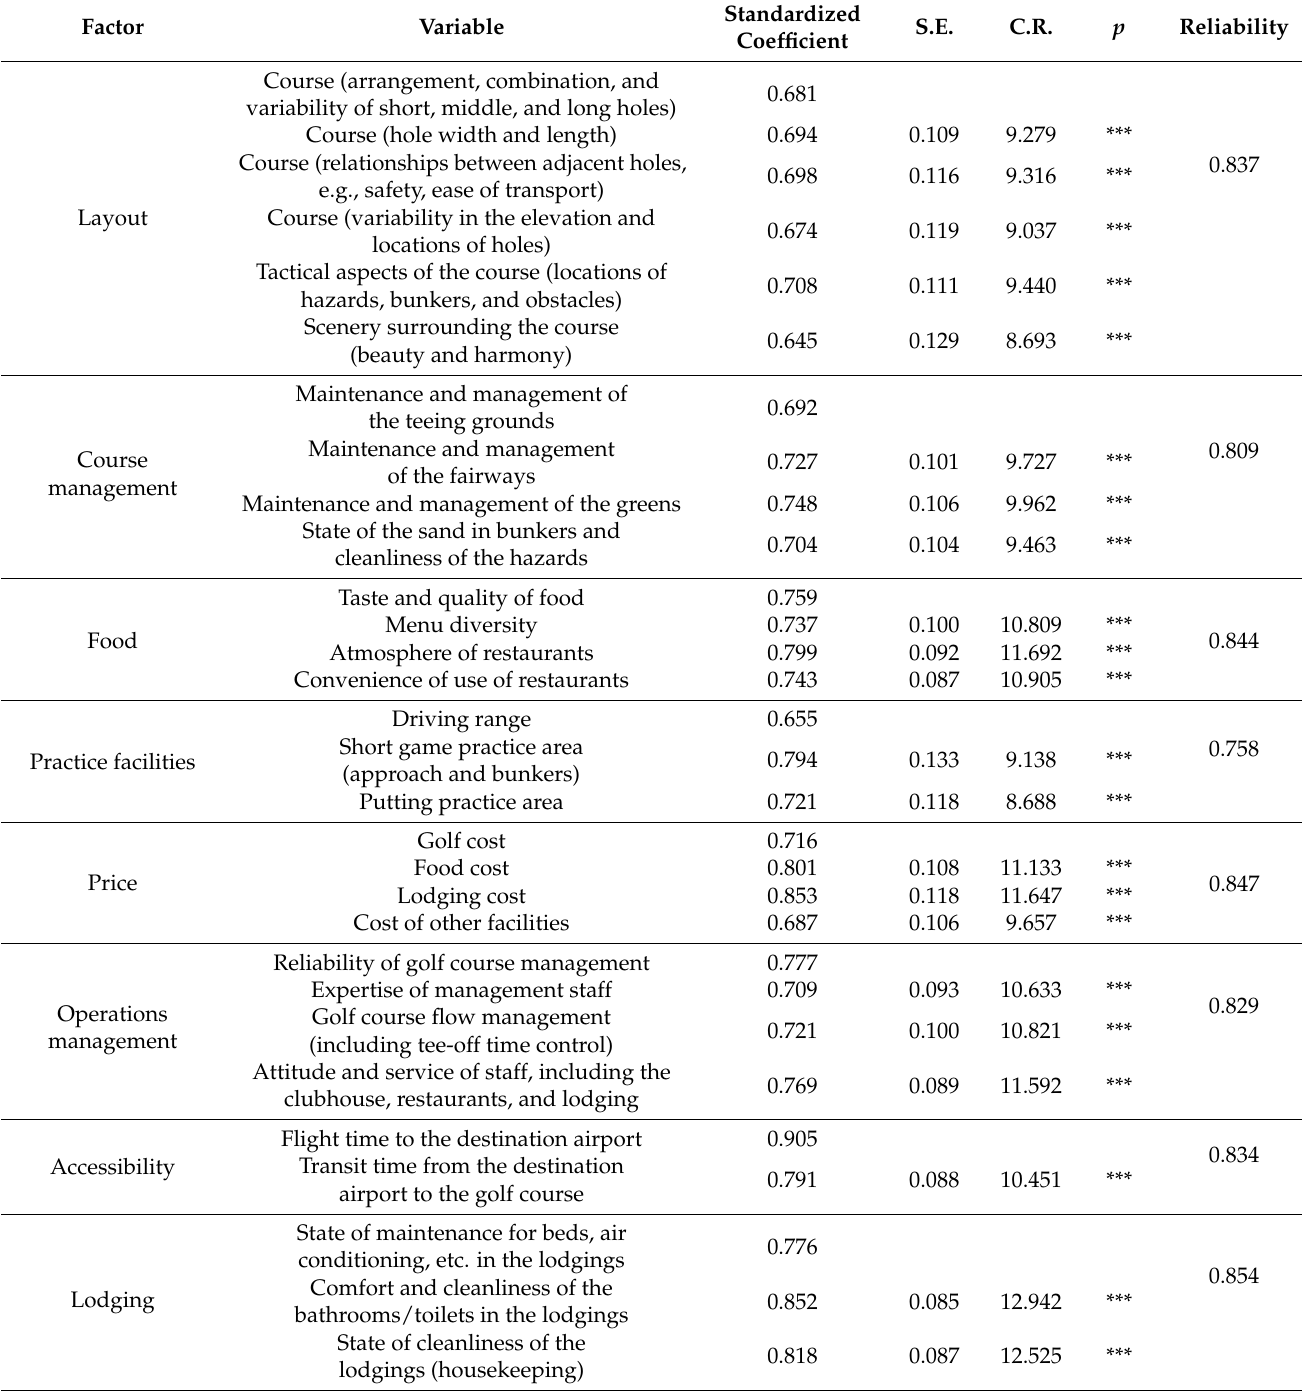
Table 4. The results of validity and reliability analysis for choice